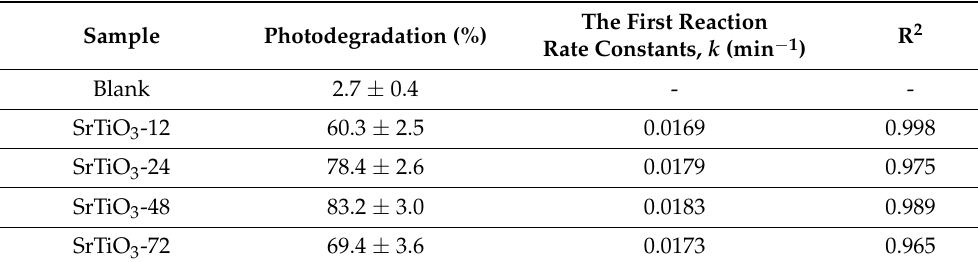
Figure 6. Photocatalytic degradation of 2-naphthol over SrTiO 3 calcined at various hydrothermal durations (hydrothermal temperature 130 ◦ C). Conditions: catalyst, 0.1 g; 2-naphthol (10 ppm, 200 mL); pH 6.3; 30 ◦ C; Exo Terra Natural Light (Repti Glo 2.0 Comp Fluor 26W PT2191-220, Illuminance: 15350 Lux, 400–700 nm). Table 3. Photodegradation data of R 2 values, rate constant ( k ), and degradation percentage for different La dopant concentrations